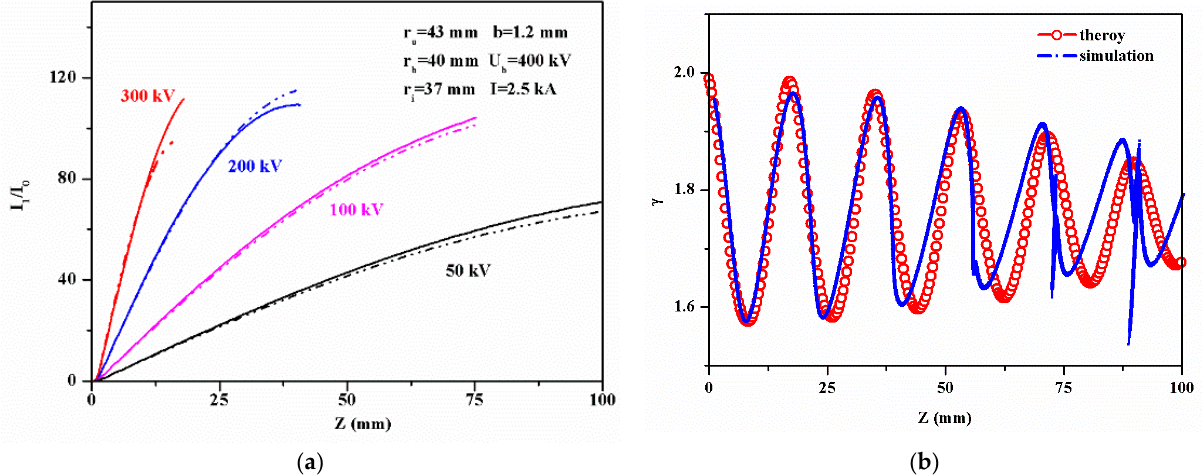
Figure 3. ( a ) The first harmonic current versus different modulation voltages: full lines show theoretical results while dotted lines show simulation results. ( b ) The velocity dispersion versus displacement Z.